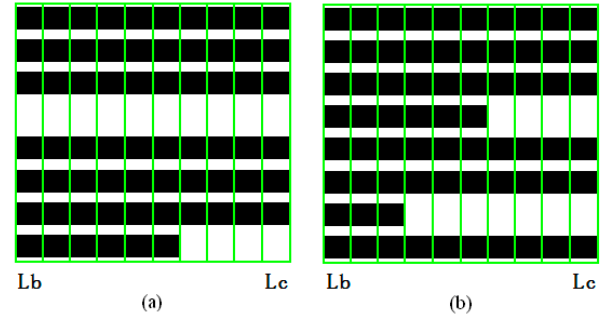
Figure 14. Distribution of pieces in area 3 of a document: ( a ) the boundary pieces L b and L c have blank blocks in the same line; ( b ) the boundary pieces L b and L c do not have blank blocks in the same line.